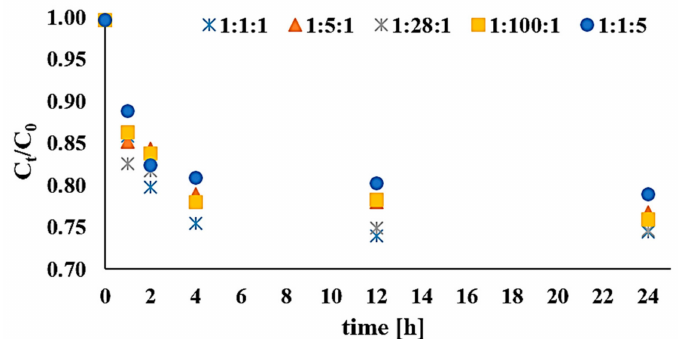
Figure 1. Impact of reagent doses in the di(2-ethylhexyl) phthalate (DEHP):H 2 O 2 :Fe 3 + molar ratio on the e ffi ciency of DEHP removal at pH 3. C t denotes the DEHP content in bottom sediments after time t, and C 0 is the initial content of di(2-ethylhexyl) phthalate in bottom